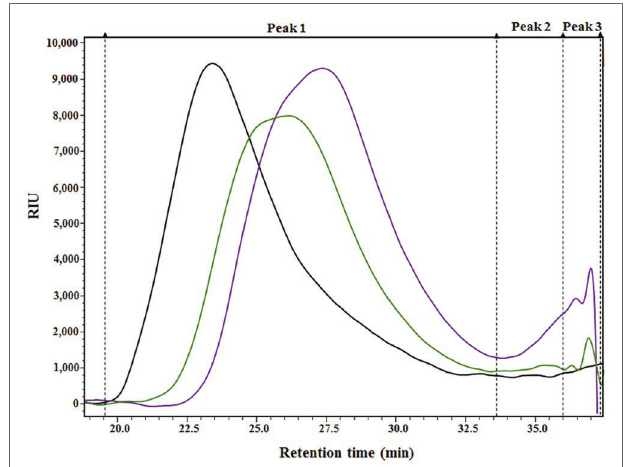
FIGURE 1 | HPSEC-RID analysis of the initial carbohydrate rich substrate and the generated Ascophyllum nodosum extract (ANE) biostimulants. Black chromatogram (AN substrate); green chromatogram (C129); purple chromatogram (PSI-494). The three main peaks were integrated and are shown in the chromatograms with dashed